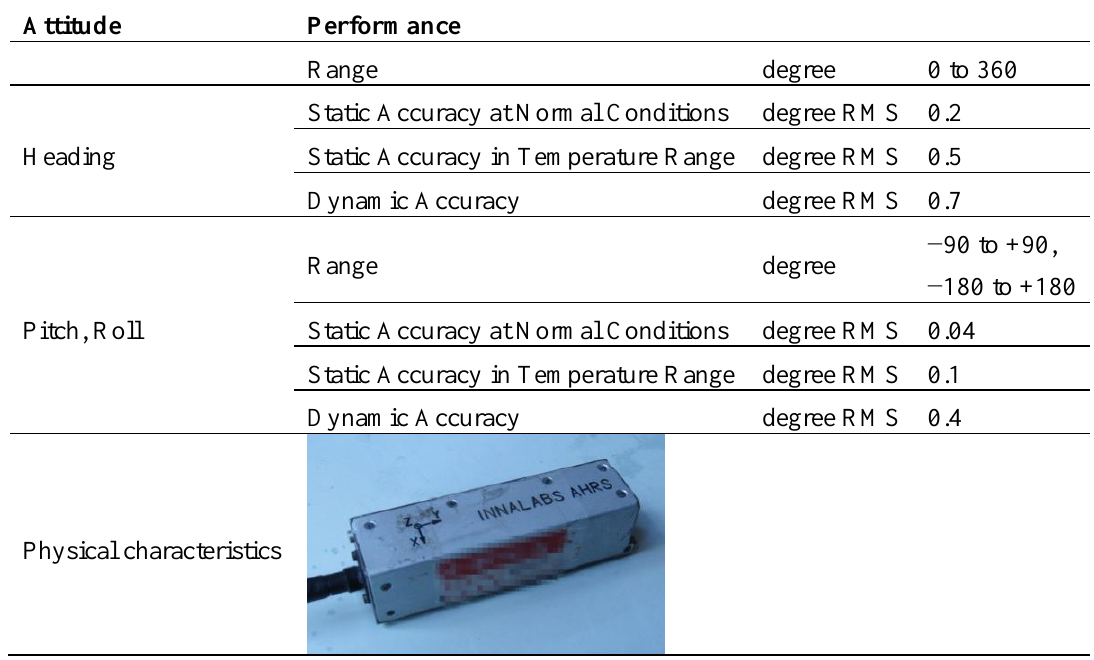
Table 9. The specifications for the attitude reference system (AHRS).